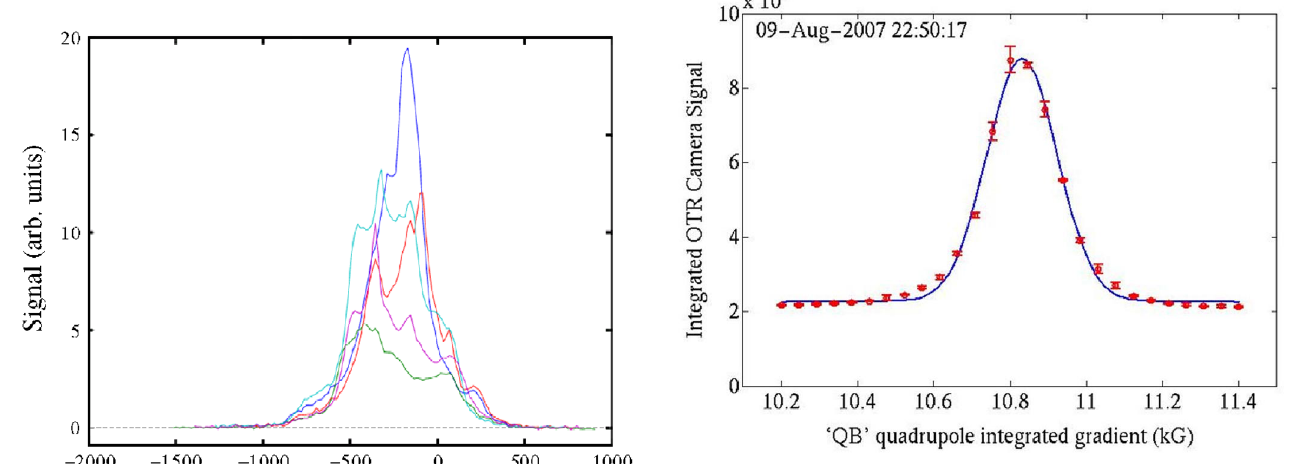
FIG. 44. (Color) The integrated optical transition radiation sig- nal (background subtracted) as a function of the QB quadrupole magnet strength. The optical signal is a maximum at the quad- rupole setting which makes the bend system a perfect linear achromat.